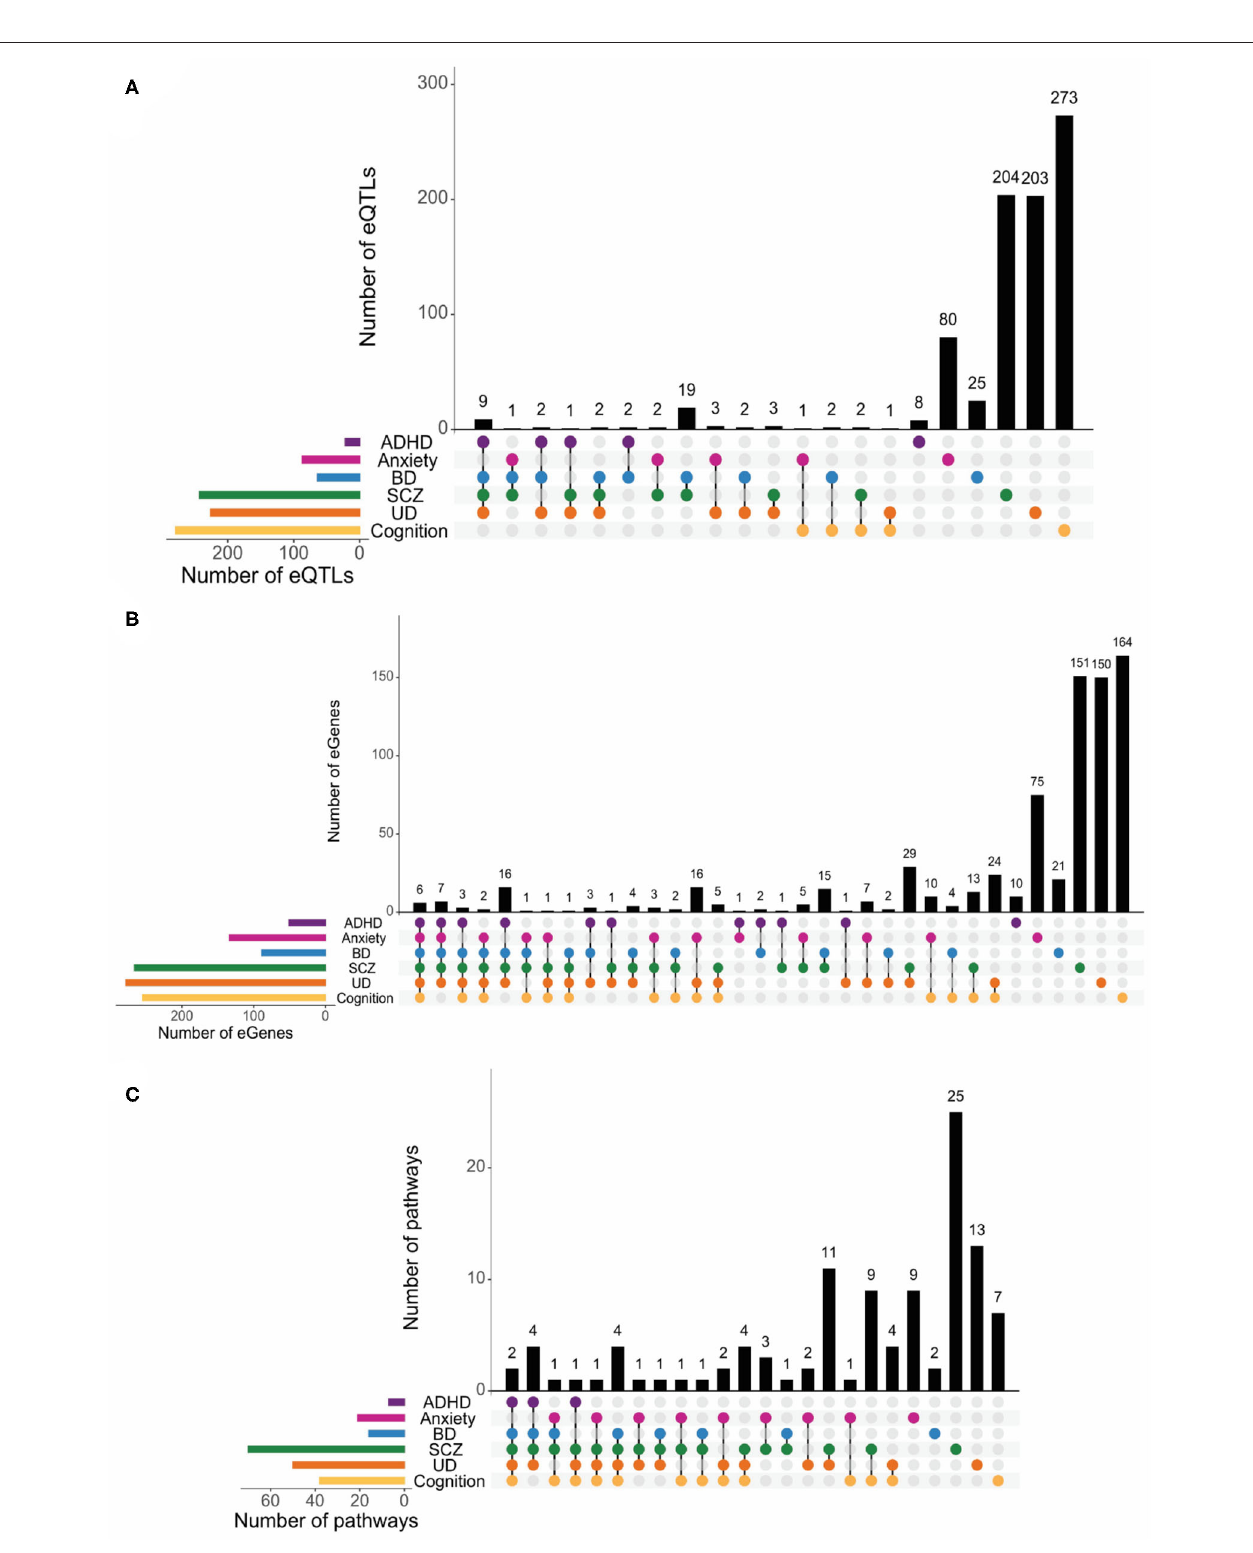
FIGURE 5 | Psychiatric disorders and cognition show no shared pathways among all phenotypes in brain tissues. Psychiatric disorders and cognitive functions have low levels of genetic similarity at the eQTLs (A) and eGene (B) levels in brain tissues. A FDR-adjusted p < 0.05 was used to identify eQTLs and eGenes. More pairwise brain-specific pathway overlaps (C) and individualized pathways were identified for psychiatric and cognitive phenotypes.